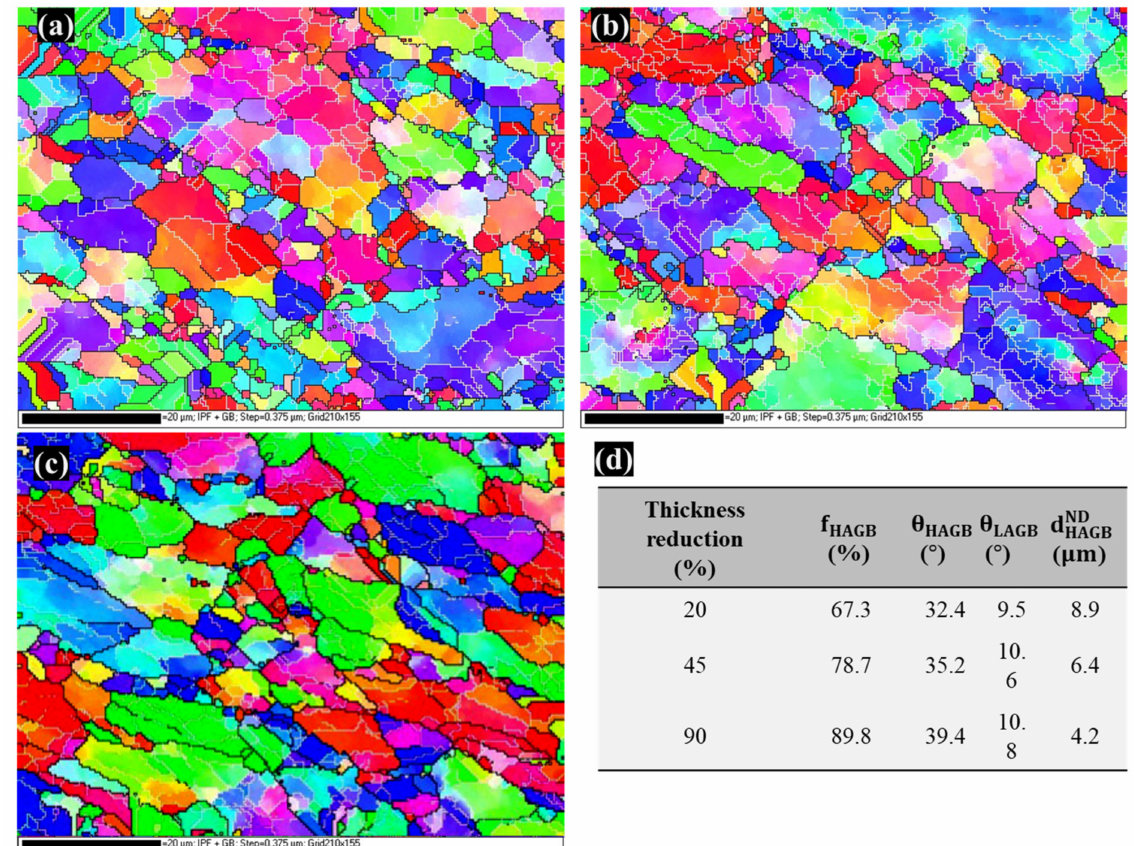
Figure 2. IPF maps of the Al/1 wt% CNT composites after ( a ) 20%, ( b ) 45%, and ( c ) 90% of thickness reduction, ( d ) HAGBs (high angle grain boundary-s) fraction (f HAGB ), LAGB (low angle grain boundary) and HAGB average misorientation angle ( θ LAGB , θ HAGB ) and HAGB spacing in normal direction (d ND ) in rolled Al/1 wt% CNT HAGB